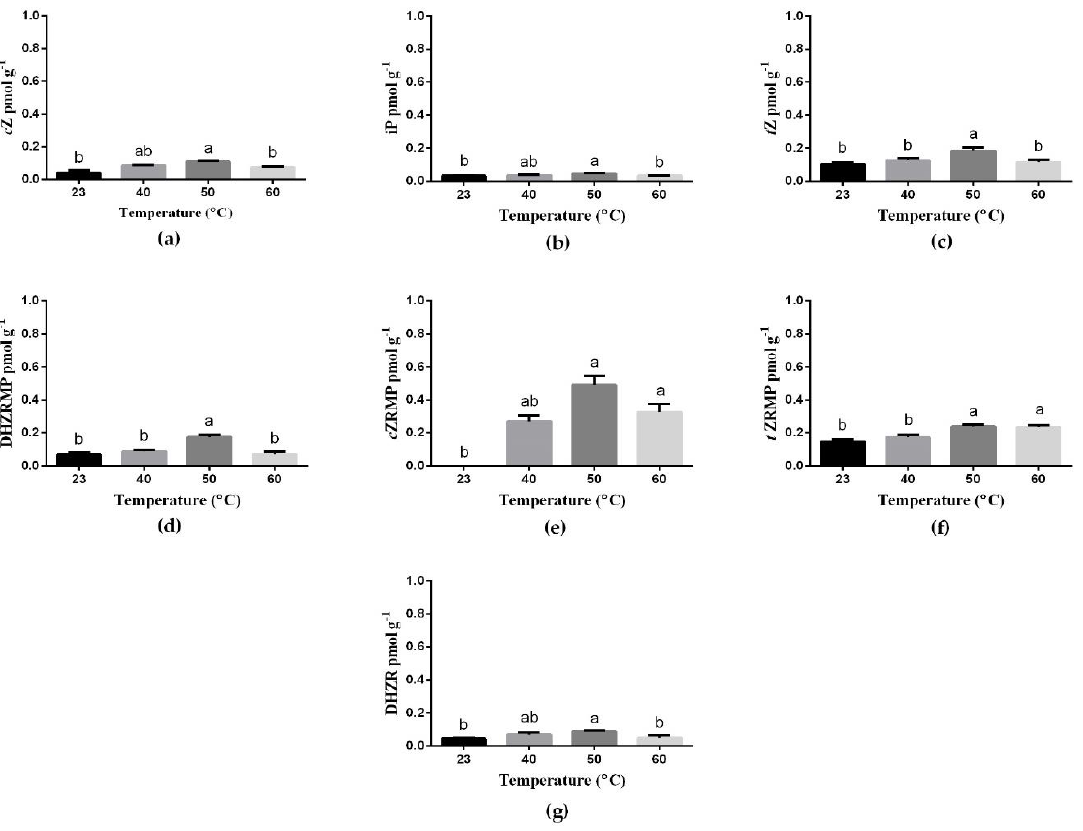
Figure 7. E ff ect of di ff erent temperatures (23 ◦ C, 9 weeks; 40 ◦ C, 4 h; 50 ◦ C, 30 min; 60 ◦ C, 5 min) Figure 7. Effect of different temperatures (23 °C, 9 weeks; 40 °C, 4 h; 50 °C, 30 min; 60 °C, 5 min) at at endogenous concentration (pmol g − 1 FW ± SE) of ( a ) c Z; ( b ) iP; ( c ) tZ; ( d ) DHZRMP; ( e ) c ZRMP; endogenous concentration (pmol g −1 FW± SE) of ( a ) c Z; ( b ) iP; ( c ) tZ; ( d ) DHZRMP; ( e ) c ZRMP; ( f ) ( f ) t ZRMP; ( g ) t ZRMP; ( g ) DHZR.